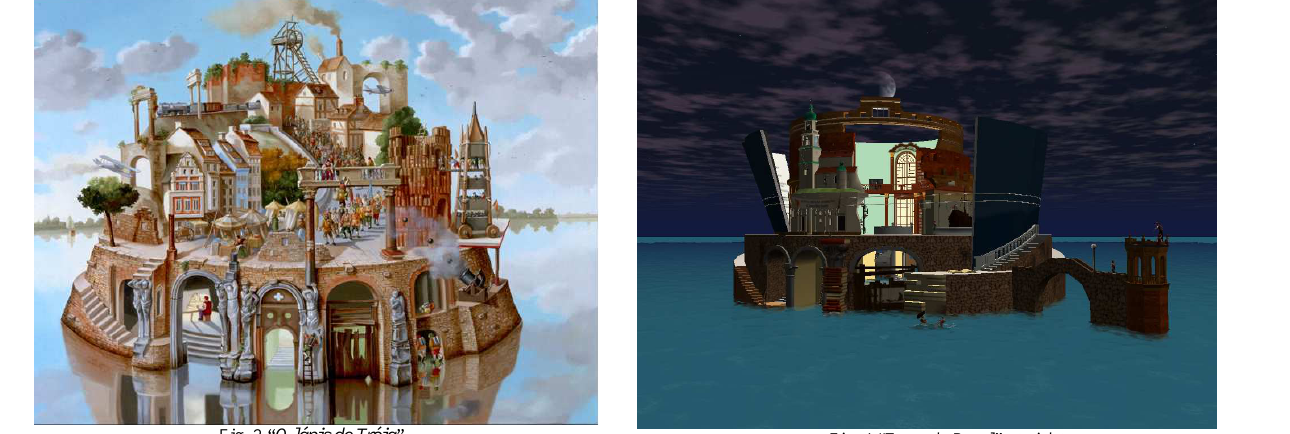
Fig. 4 “Torre de Papel” at night.